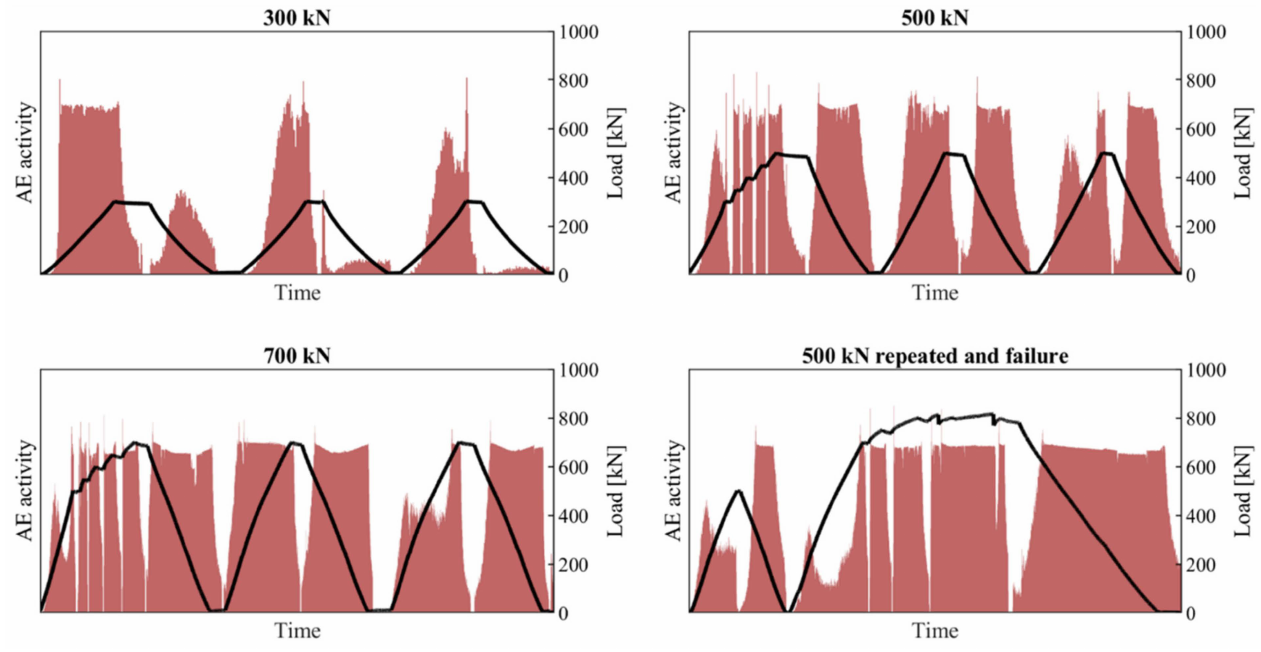
Figure 15. Global AE activity level for all load